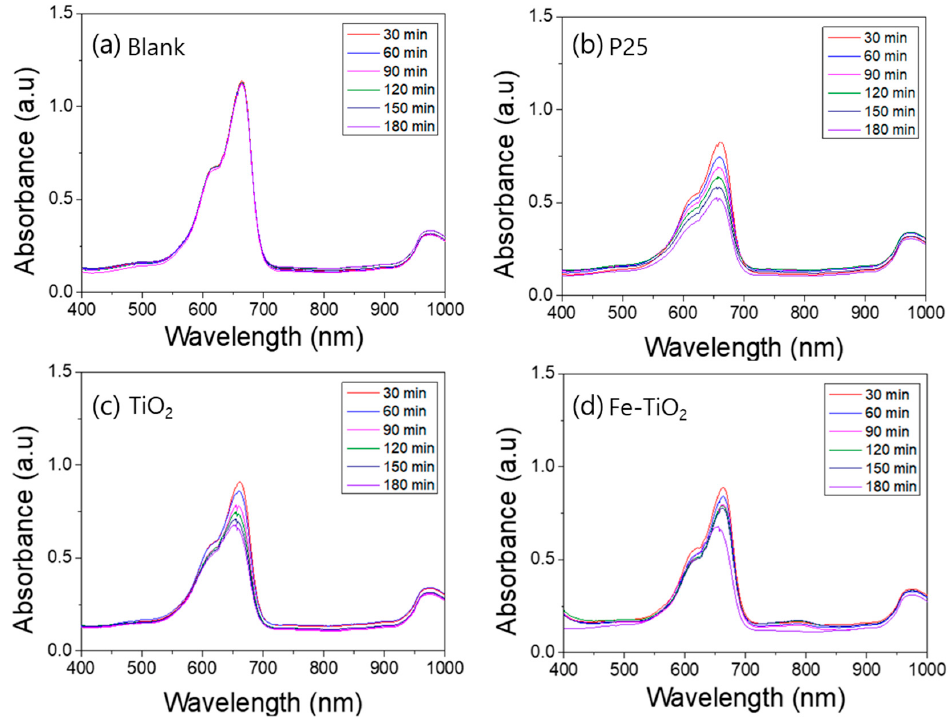
Figure 9. UV–Vis absorption spectra of the ultraviolet photocatalytic degradation of an aqueous acid orange 7 solution by nanofibers: ( a ) blank, ( b ) P25, ( c ) TiO 2 nanofibers, ( d ) Fe-doped TiO 2 nanofibers. Polymers 2021 , 11 , x FOR PEER REVIEW